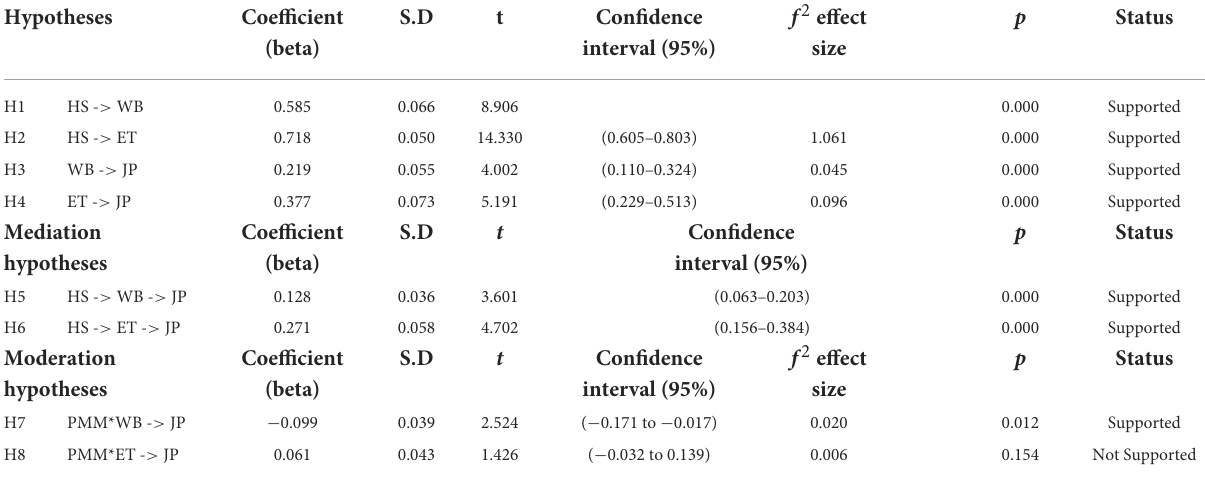
TABLE 5 Hypotheses